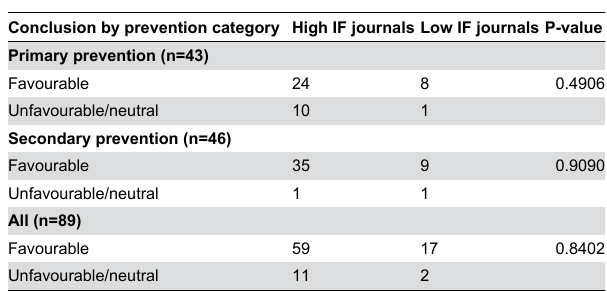
Table 5. Study conclusions by journal impact